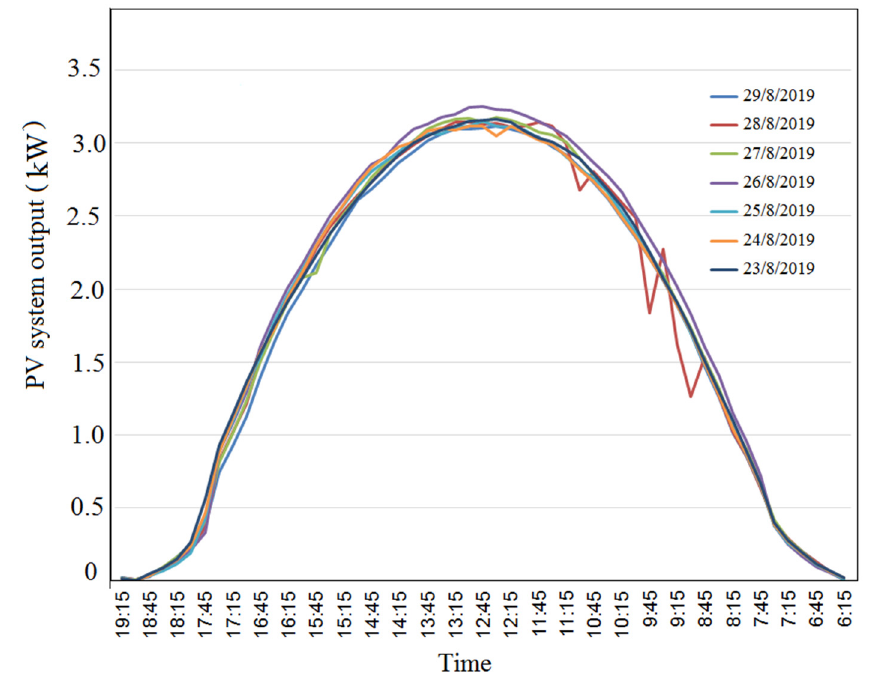
Figure 3. An example for a single household PV system output (House 5) over one week with sunny day.